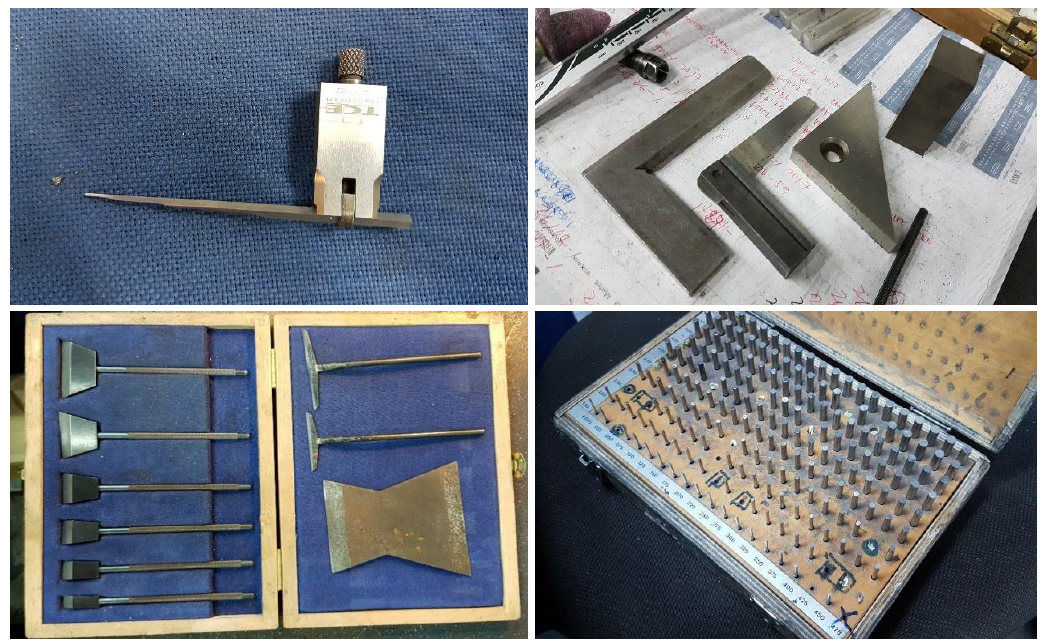
Figure 7. Common inspection tools: right-angle gauge ( top left ); try-square set ( top right ); various types of straight edges ( bottom left ); pin gauge set ( bottom right ).